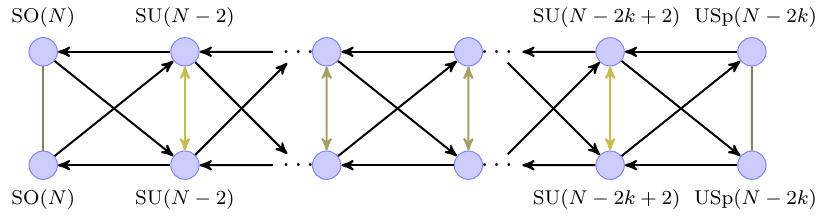
Figure 29. The general quiver of family B models. Colored fields are the mass deformed pairs. b even) the orientifold projection is realized on the five-brane diagram by means of fixed points that are shifted horizontally by a quarter of a period with respect to the case of family A , while for a = b the projection is realized by means of fixed lines. The resulting quiver in drawn in figure 29, where as in the previous case the colored fields have unit R -charge and they are progressively integrated out along the